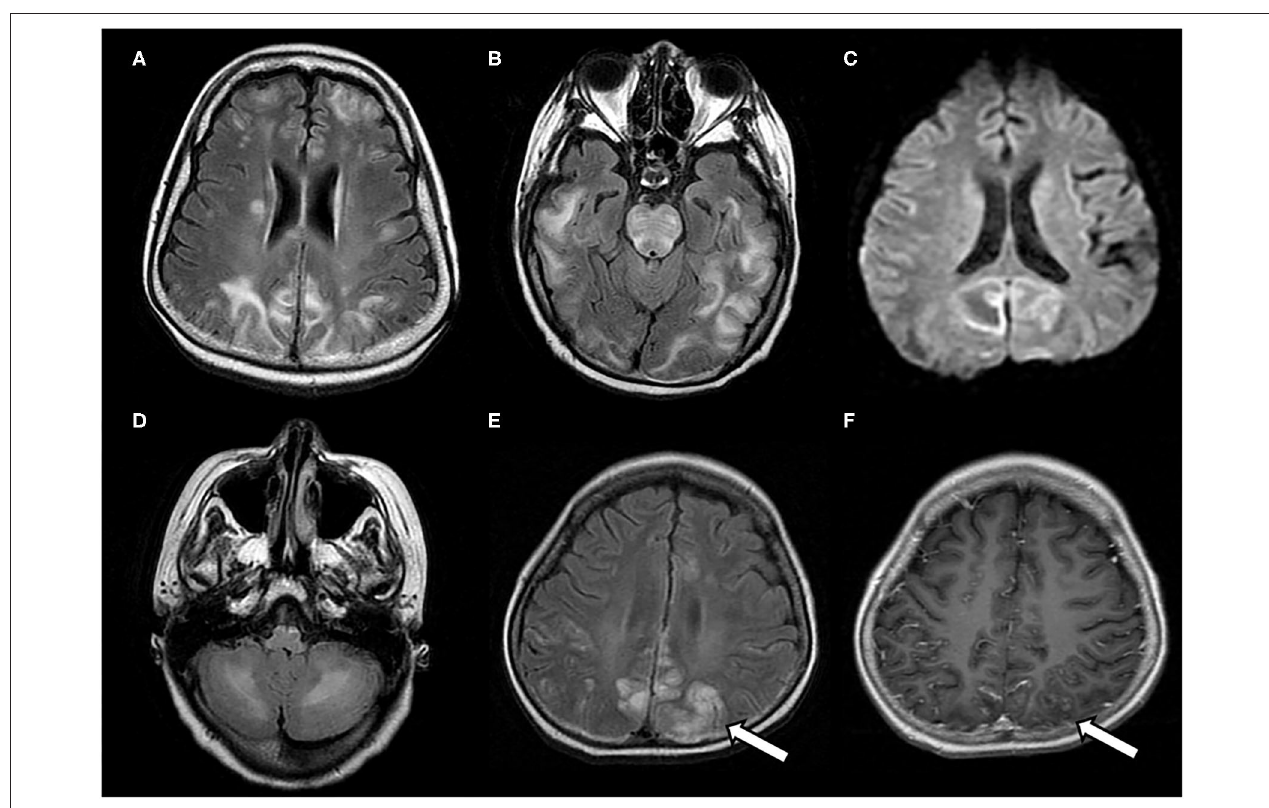
FIGURE 2 | Atypical neuroimaging findings of PRES. (A,B) In a 17-year-old female with underlying systemic lupus erythematosus, lesions diffusely involving cerebral hemispheres, basal ganglia, and brain stem, with a prominent asymmetry on FLAIR images. (C) In a 12-year-old female with nephritic syndrome, MRI showed paradoxically hyperintense lesions on DWI (restricted diffusion) in bilateral occipital lobes. (D) In a 14-year-old male with membranoproliferative glomerulonephritis who showed prominent lesions of bilateral cerebellar hemispheres in FLAIR images (E,F) In an 8-year-old male with nephrotic syndrome, MRI showed occipital lesions hyperintensities on FLAIR, which also demonstrate post-contrast enhancement on T1-weighted image (white